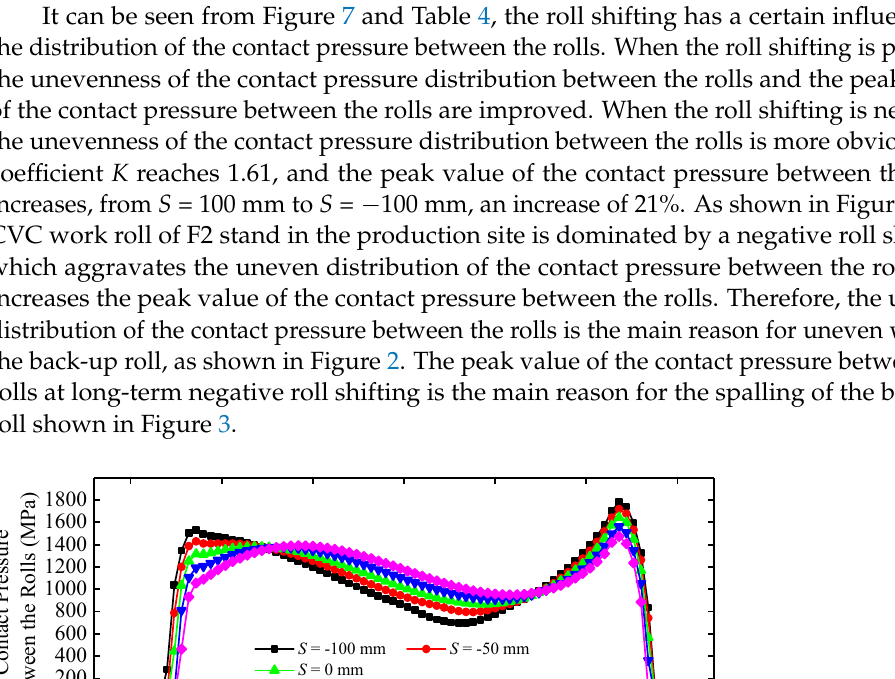
Table 3. The coefficient K at different rolling forces q . Table 2. The coefficient K at different strip widths B .